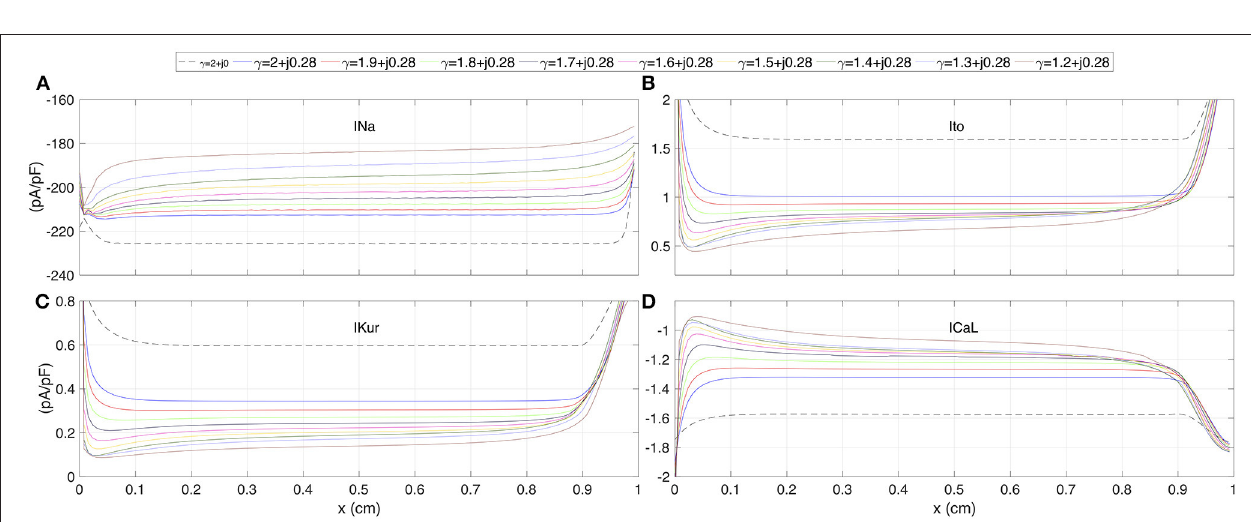
FIGURE 4 | The spatial profiles of ionic current peaks for several test values of γ . (A) Sodium current INa . (B) Outward transient potassium current Ito . (C) Ultrarapid delayed rectifier potassium current IKur . (D) L-type calcium current ICaL . Dashed line corresponds to standard diffusion and colored curves correspond to test values of γ